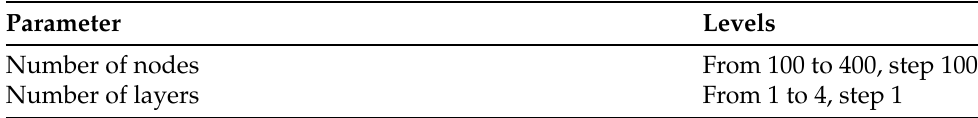
Table 3. Parameters and levels of use in grid search.